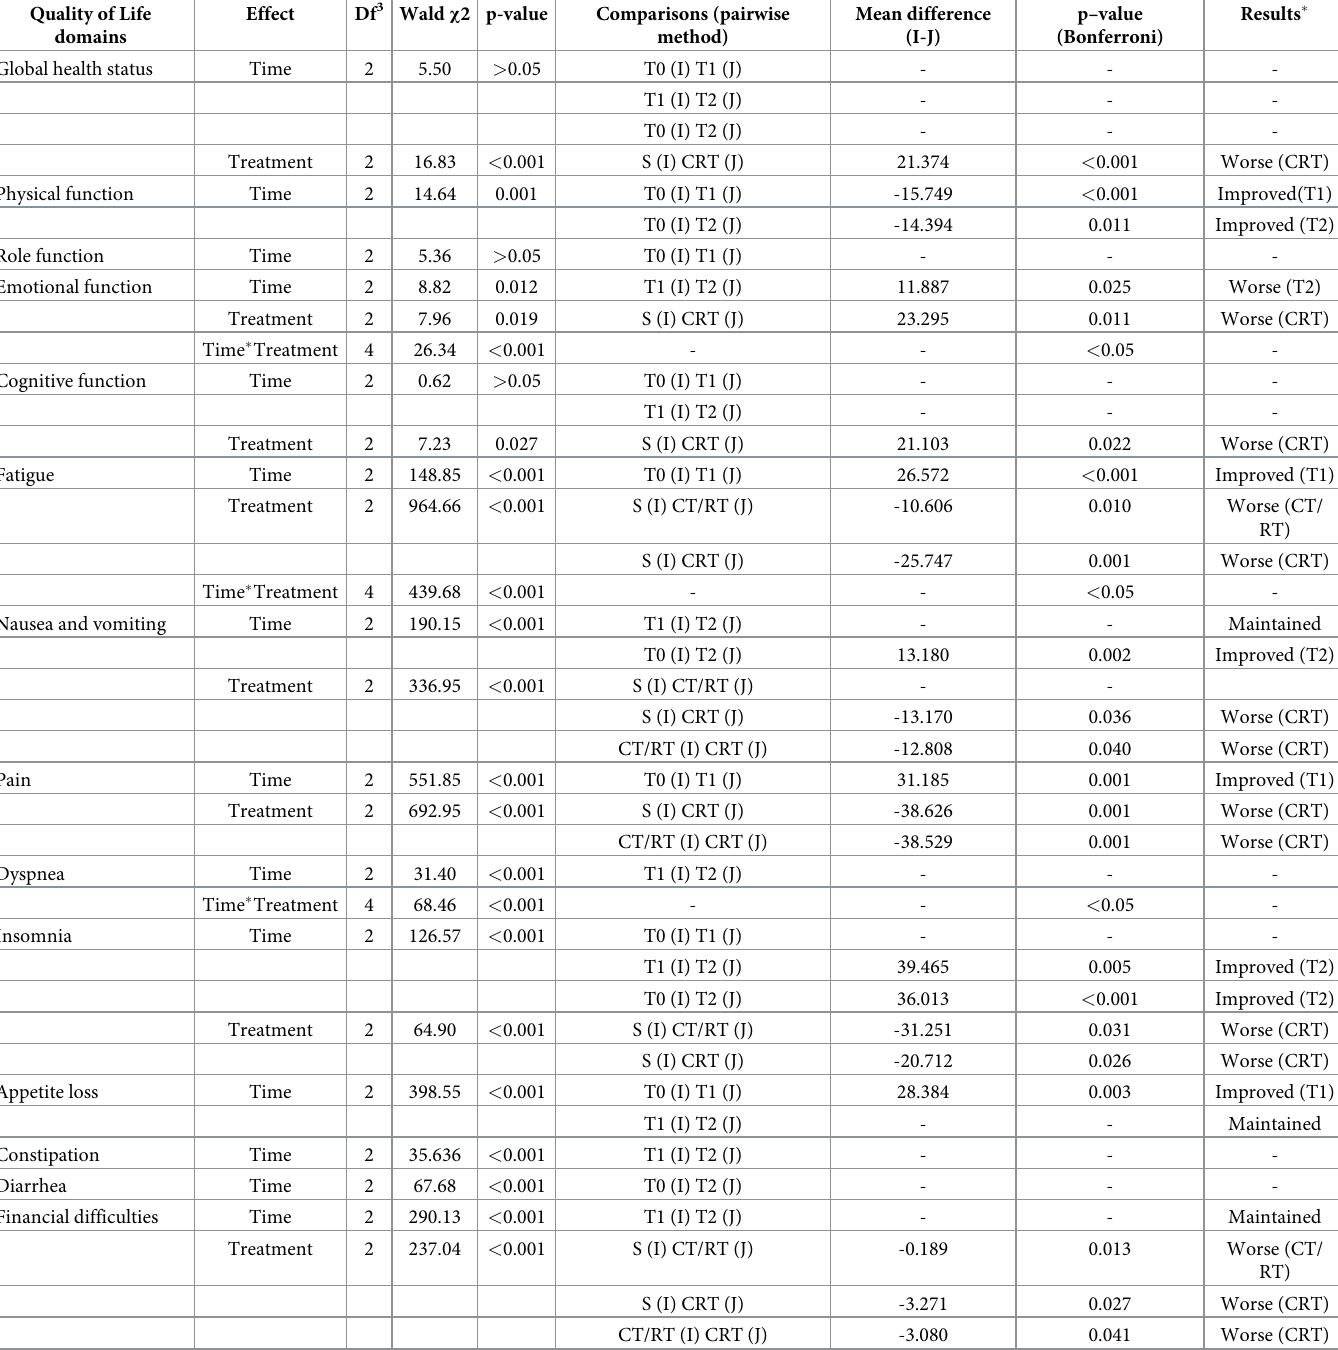
Table 4. Model effect, comparisons and post hoc tests of the variables of quality of life of EORTC QLQ-C30 with time and treatment factors using Generalized Esti- mating Equations. Quality of Life